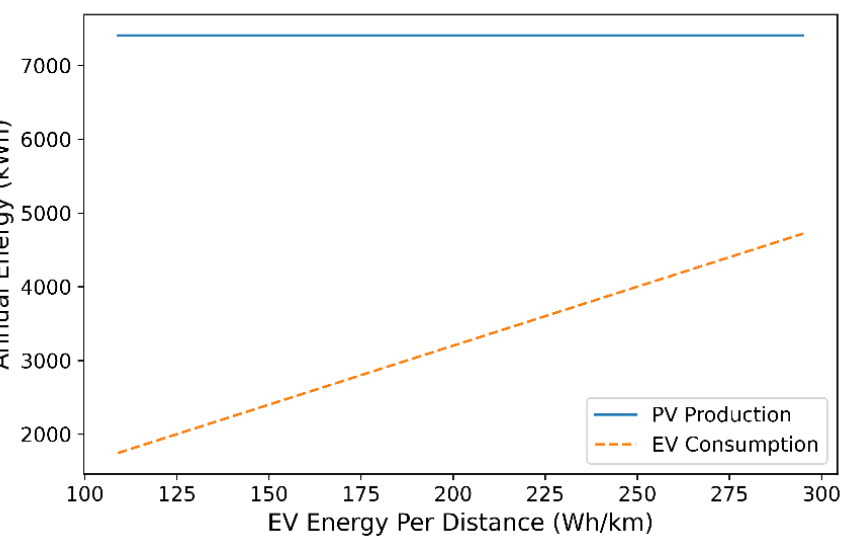
Figure 16. Comparison of the annual energy production of a single PV carport using a 20.51% efficient PV (reference efficiency) relative to the average annual energy needs of a single EV in London, Ontario. The value current EVs on the market is used for the EV energy per distance.